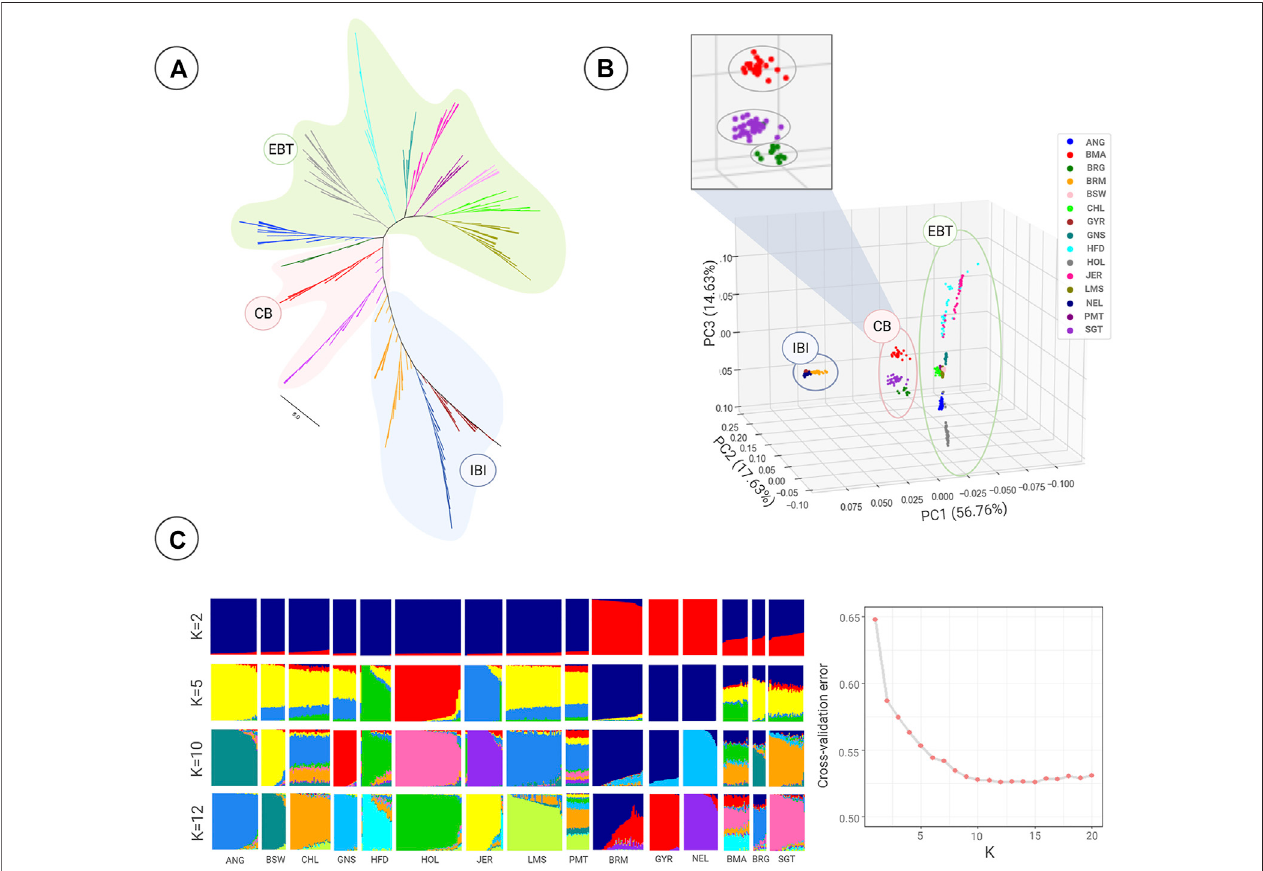
FIGURE 1 | Population structure and relationship of European Bos taurus taurus (EBT), Indian Bos taurus indicus (IBI), and composite beef cattle (CB) breeds tested in this study using genome-wide SNPs. (A) A neighbor-joining phylogenetic tree was constructed using whole-genome SNP data. The scale bar represents pairwise distances between different individuals. Colors re fl ect the different geographic regions of samples. (B) Principal component analysis showing PC1 against PC2 andPC3. (C) Model-basedclusteringof15cattlebreedsusingadmixtureanalysiswiththeassumednumberofancestriesof2,5,10,and12.Thelinearplotshows the cross-validation error as a function of K for admixture analysis. Abbreviations of all breeds are given in Table 1 .